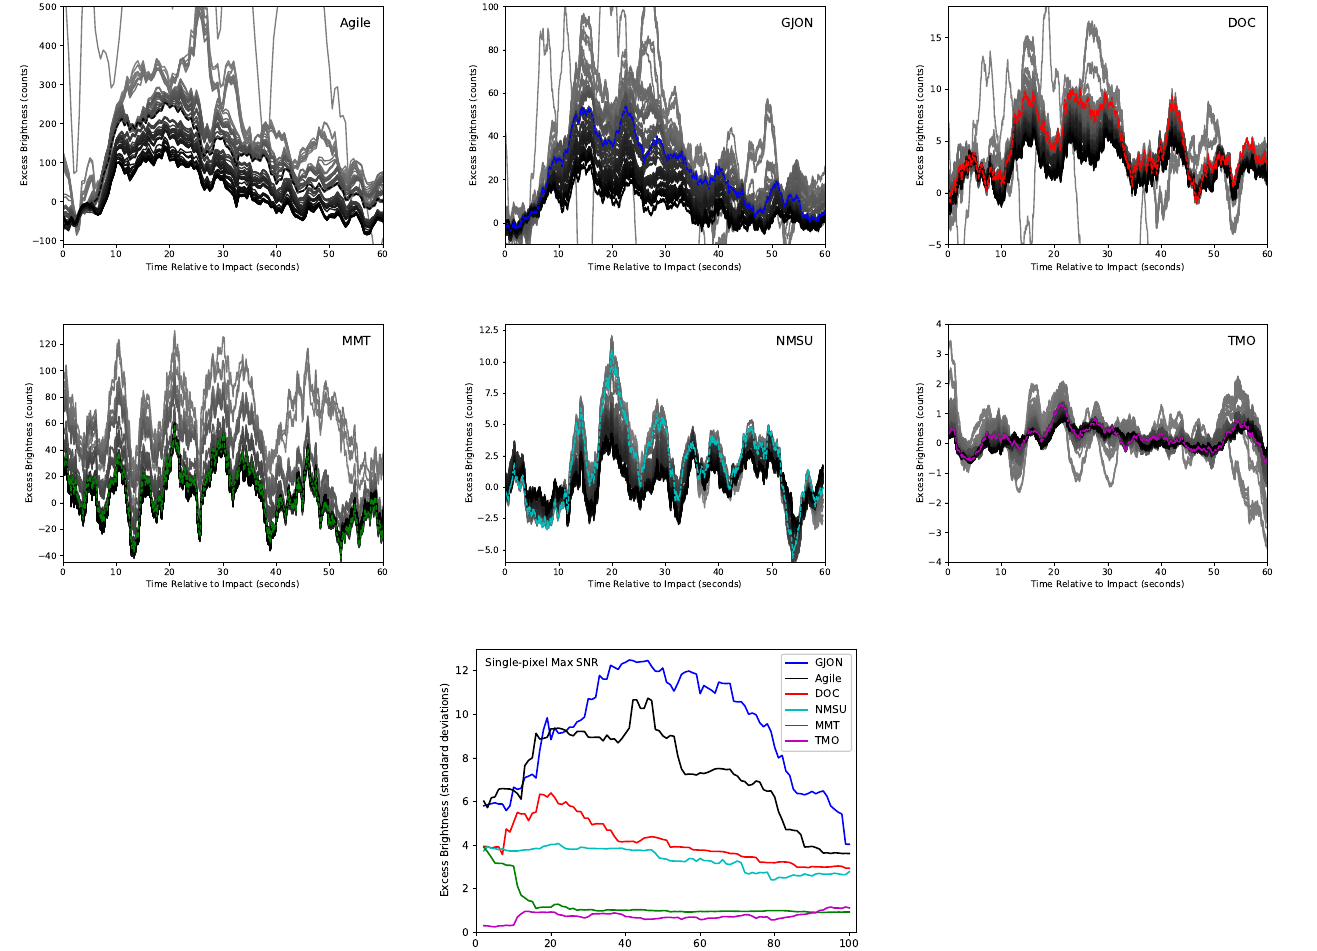
Figure 5. The small panels contain PCA-filtered lightcurves from CSE. These show excess counts for the first minute after impact at the maximum SNR pixel (see Figure 4) with a 2.5 s boxcar average (We assume the use of PCA-filtered data with a 2.5 s boxcar average for all subsequent figures). The lightest shade of gray is PCA filtering by removing only PC1, and shading darkens with increasingly higher PCs filtered in CSE. The line becomes black when PCs 1–100 are removed for all cameras except for TMO, for which black represents PCs 1–300 removed. The dashed line indicates the lightcurve at the level of PCA filtering chosen based on the maximum SNR shown in the lower panel. The lower panel shows the SNR achieved through CSE of PCs from each data set. We averaged the excess brightness at the maximum SNR pixel (see Figure 4) over 15 to 33 s after impact for all cameras except for NMSU, for which we narrowed the window to 17 to 23 s after a non-detection using the broader